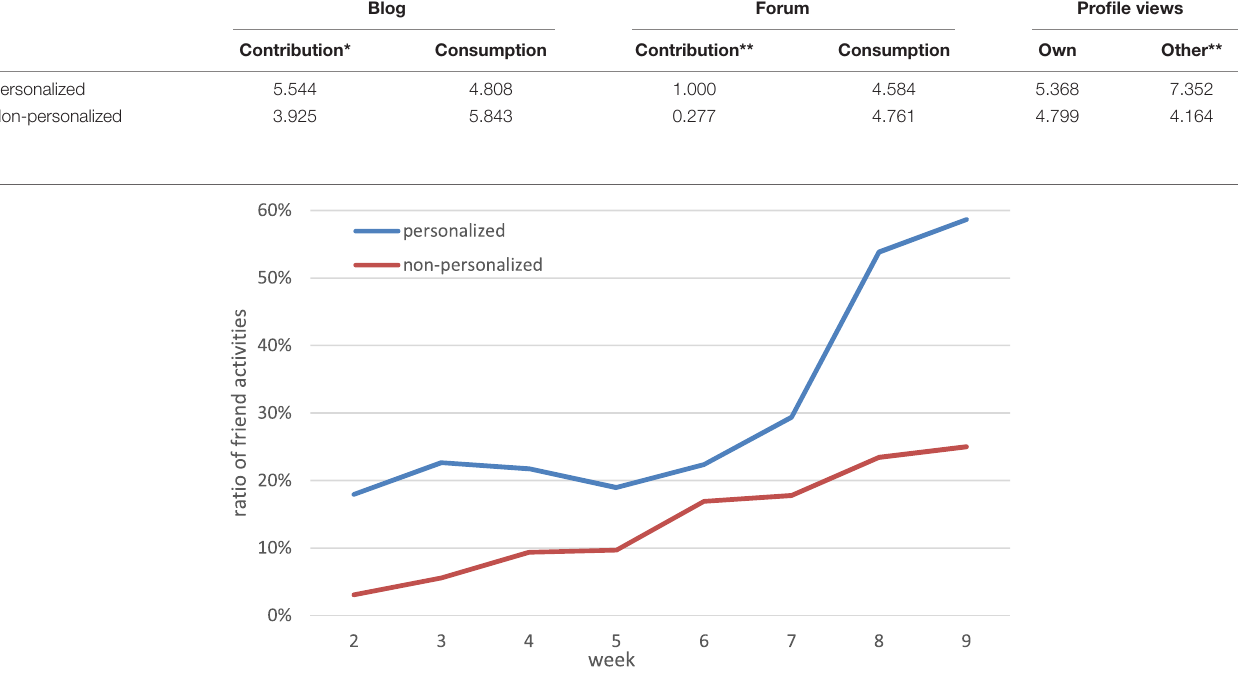
FigUre 9 | ratio of friend activities in the feeds .